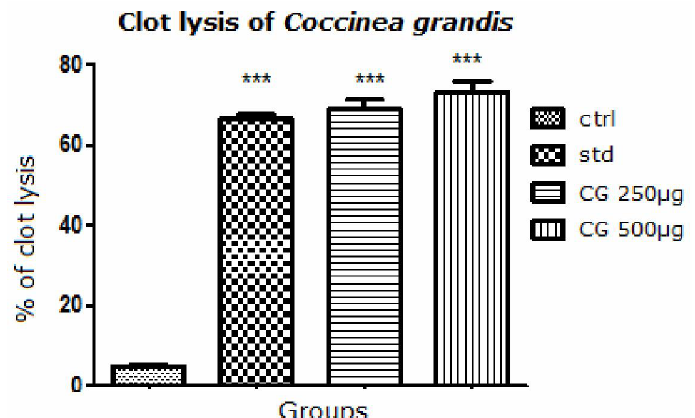
Figure 1. Evaluation of thrombolytic activity of Coccinea grandis (Values are expressed as mean ± SEM (n = 10) , *** (p<0.001) vs